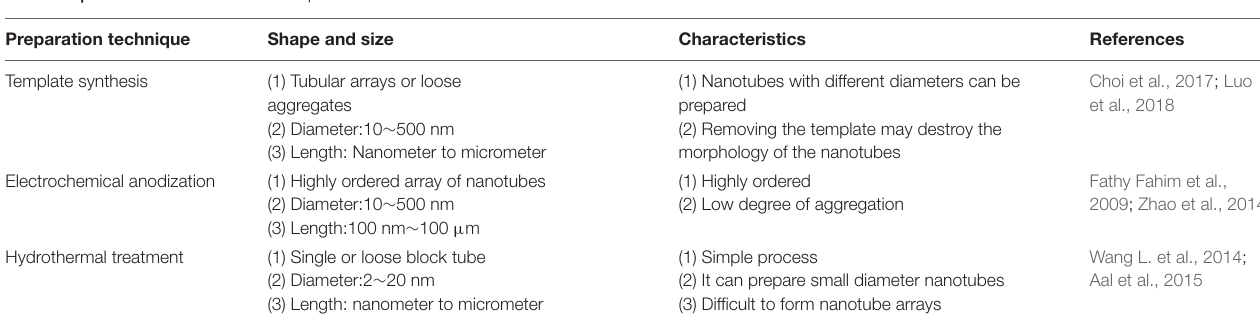
FIGURE 2 | A schematic representation of preparation procedure for various nanoparticles. TABLE 1 | Different nanotube formation